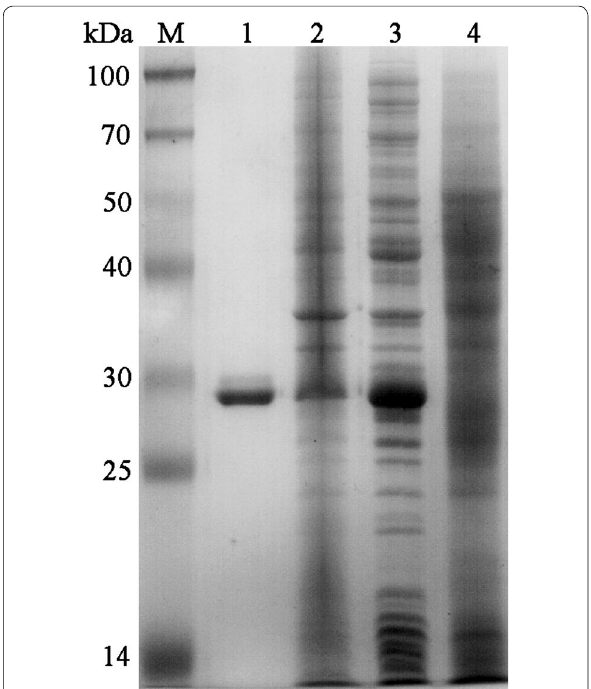
Fig. 2 SDS‑PAGE analysis of expressed and affinity column puri‑ fied SBP‑Cap∆41 protein. M protein marker; 1 purified SBP‑Cap∆41 protein; 2 pellet of cell lysate after sonication and centrifugation; 3 supernatant of cell lysate after sonication and centrifugation; 4 lysates of pET‑28a( ) expressing cells +